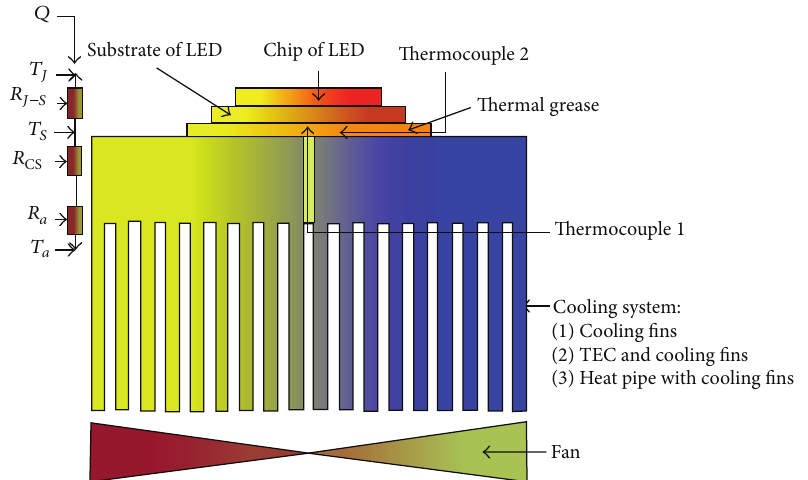
Figure 1: Schematic diagram of the LED system and thermal equivalent circuit of the heat transfer mechanism.